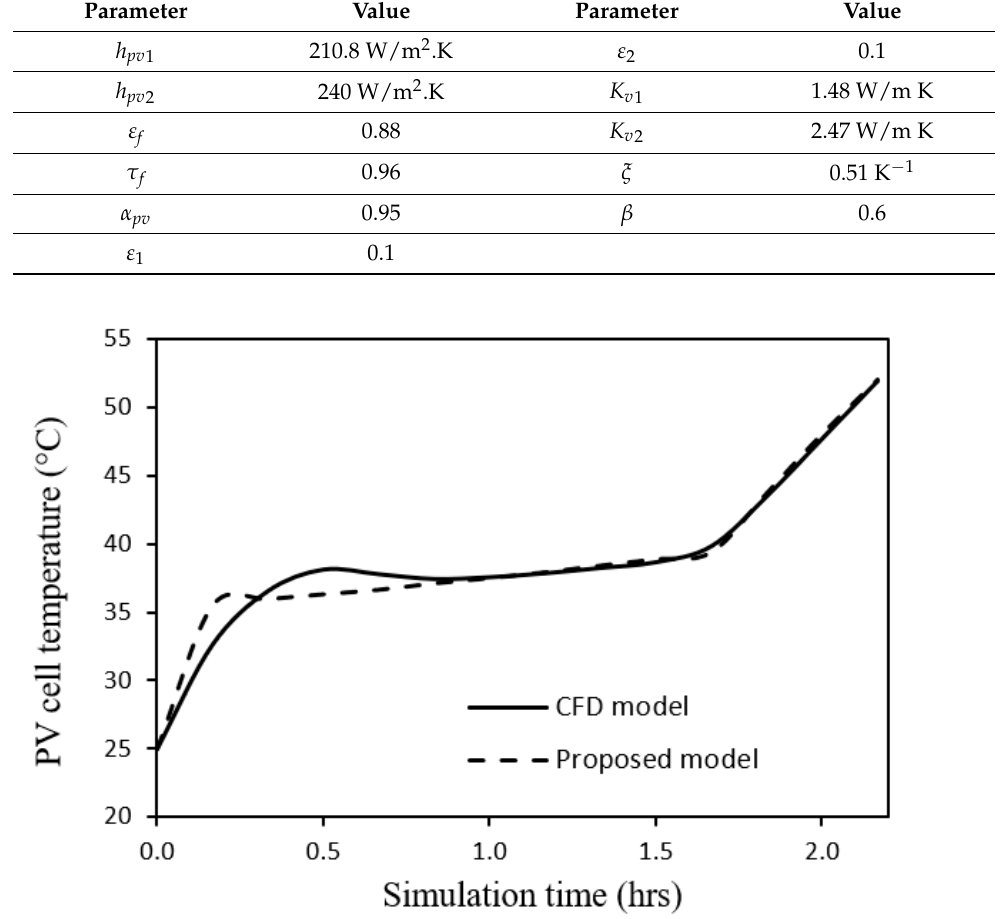
Figure 3. Time profiles of PV cell temperature by the CFD model and the proposed model.